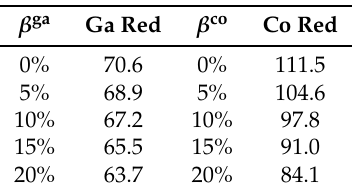
Table 1. Wind LCOEs P LC,wi for the two different integration strategies described in the text. A wind α , β penetration value ¯ w wi = 40% is